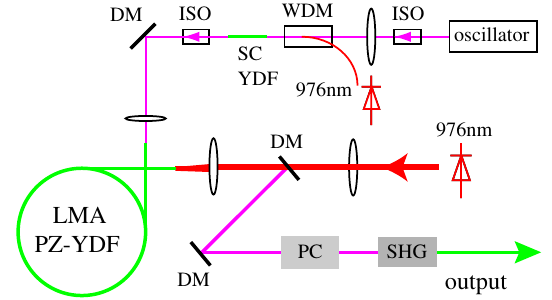
FIG. 2. Schematic of 50 MHz laser system: LMA, large mode area; PZ-YDF, single-polarization Yb-doped fiber; WDM, wave- length division multiplexer; SC, single clad; ISO, optical isolator; DM, dichroic mirror; PC, Pockels cell; SHG, second harmonic